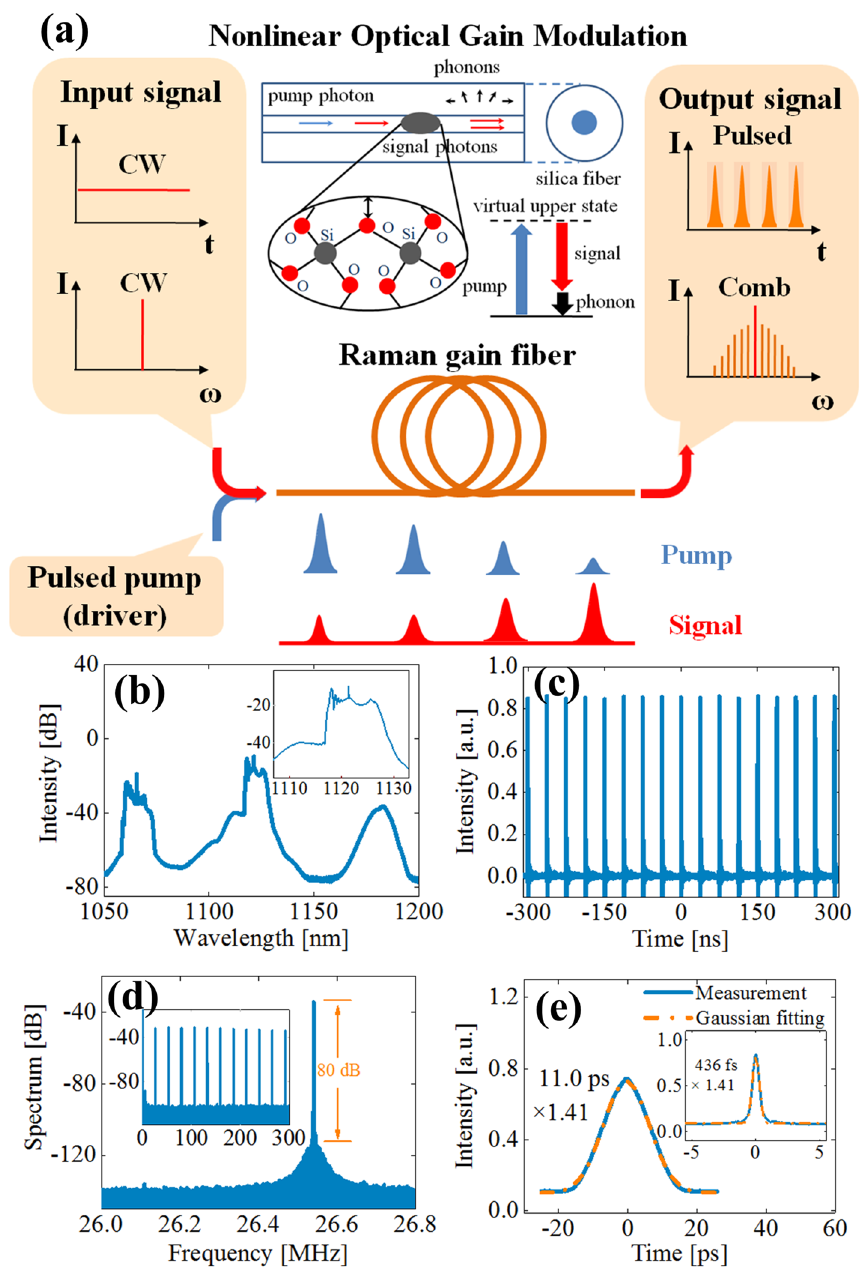
Fig. 13 Principle of NOGM ( a ); Characteristics of the experimental generated NOGM Raman pulses: ( b ) spectrum, ( c ) pulse train, ( d ) RF spectrum and ( e ) autocorrelation traces